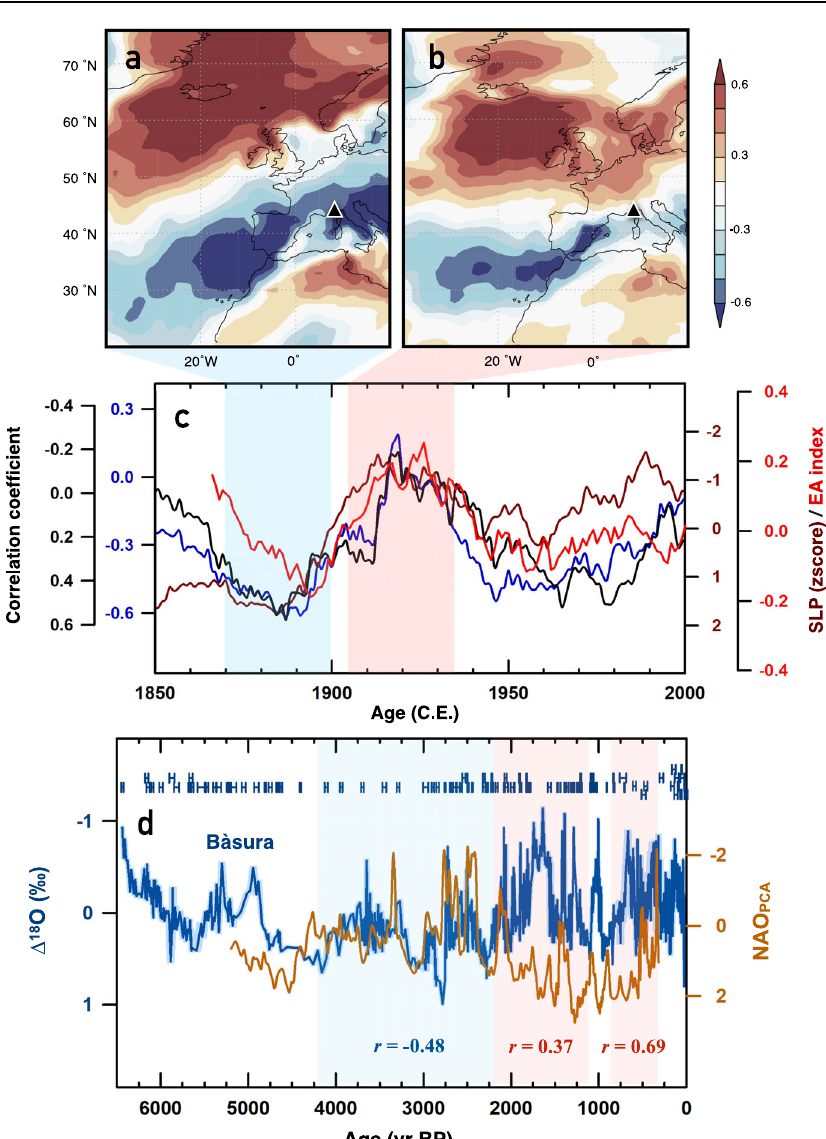
Fig. 1 | Decadal to millennial non-stationary North Atlantic Oscillation (NAO) behaviors. a Correlation of winter (December-February) precipitation and NAO index 39 during 1870 – 1900 C.E.Note thatthe reanalysisof periodsbefore1920 C.E. is not as reliable as those after 1920 C.E. due to the lack of observation data in NCAR/NCEP Reanalysis v3. b as a , but for 1905 – 1935 C.E. Color-coded shadows in a and b show the correlation coef fi cient. Black triangle edged white marks the location of Bàsura cave. c Black: 30-year window running correlation between December-March (DJFM) Toirano precipitation (averaged in [45 – 48°N, 5 – 10°E]) and W Greenland temperature (averaged in [63 – 68°N, 60 – 50°W]); blue: 30-year window running correlation between DJFM Toirano precipitation (averaged in [45 – 48°N, 5 – 10°E]) and NAO index 39 ; brown: 10-year moving average of DJFM sea- level pressure (SLP) at [52.5°N, 27.5°W]); red: 10-year moving average of